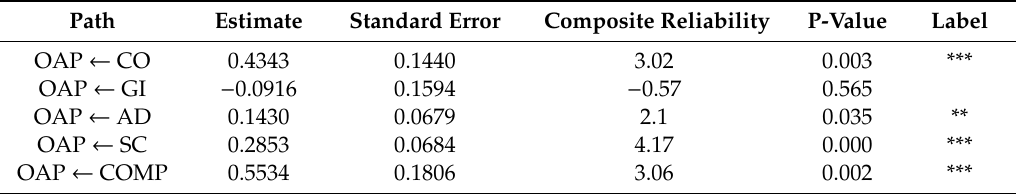
Table 5. Regression weights and covariances for the SEM model.